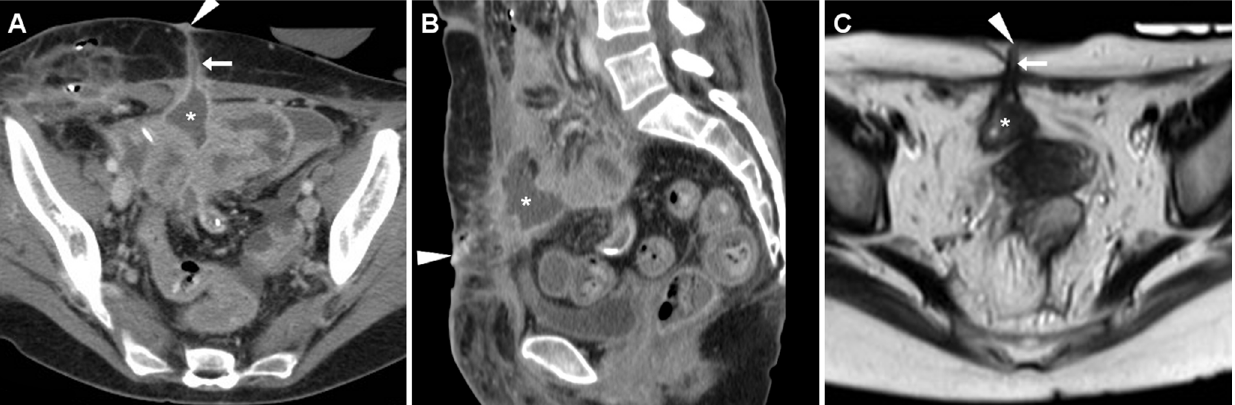
a peripherallyenhancingcollection (*)whichultimatelyresolved.In a 48- year-old woman with recent CD resection, T2-weighted MRI ( C ) depicted a chronic postsurgical collection (*) connected to the skin by a fistula (arrows)